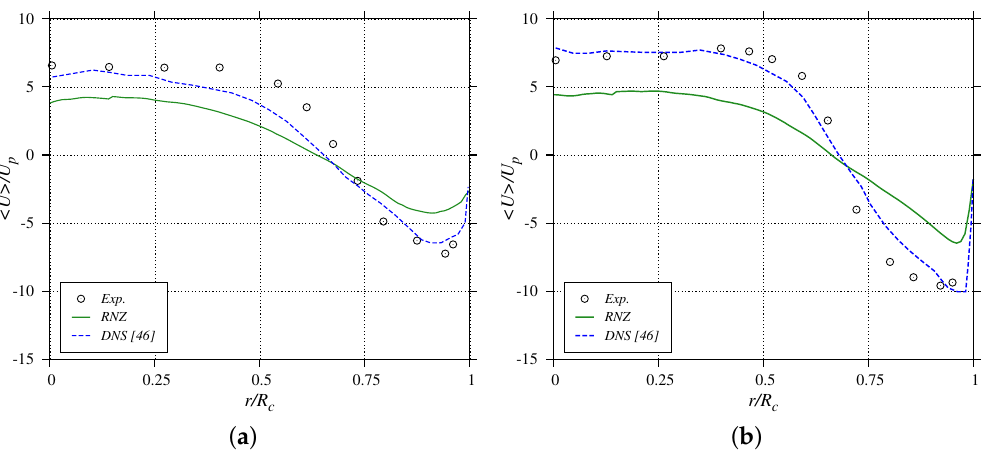
Figure 10. Radial distribution of the averaged axial velocity < U > at θ = 144 ◦ : ( a ) z = − 20 mm; ( b ) z = − 30 mm.